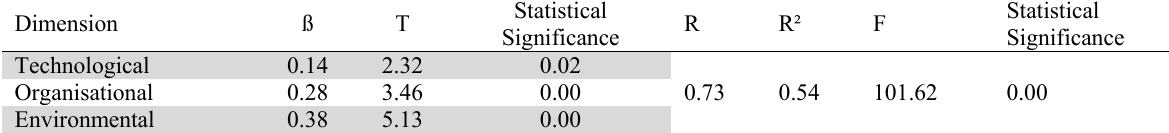
Results of Applying the Multiple Regression Equation to Study the Impact of Adopting E-Collabora- tion Tools on Knowledge Application